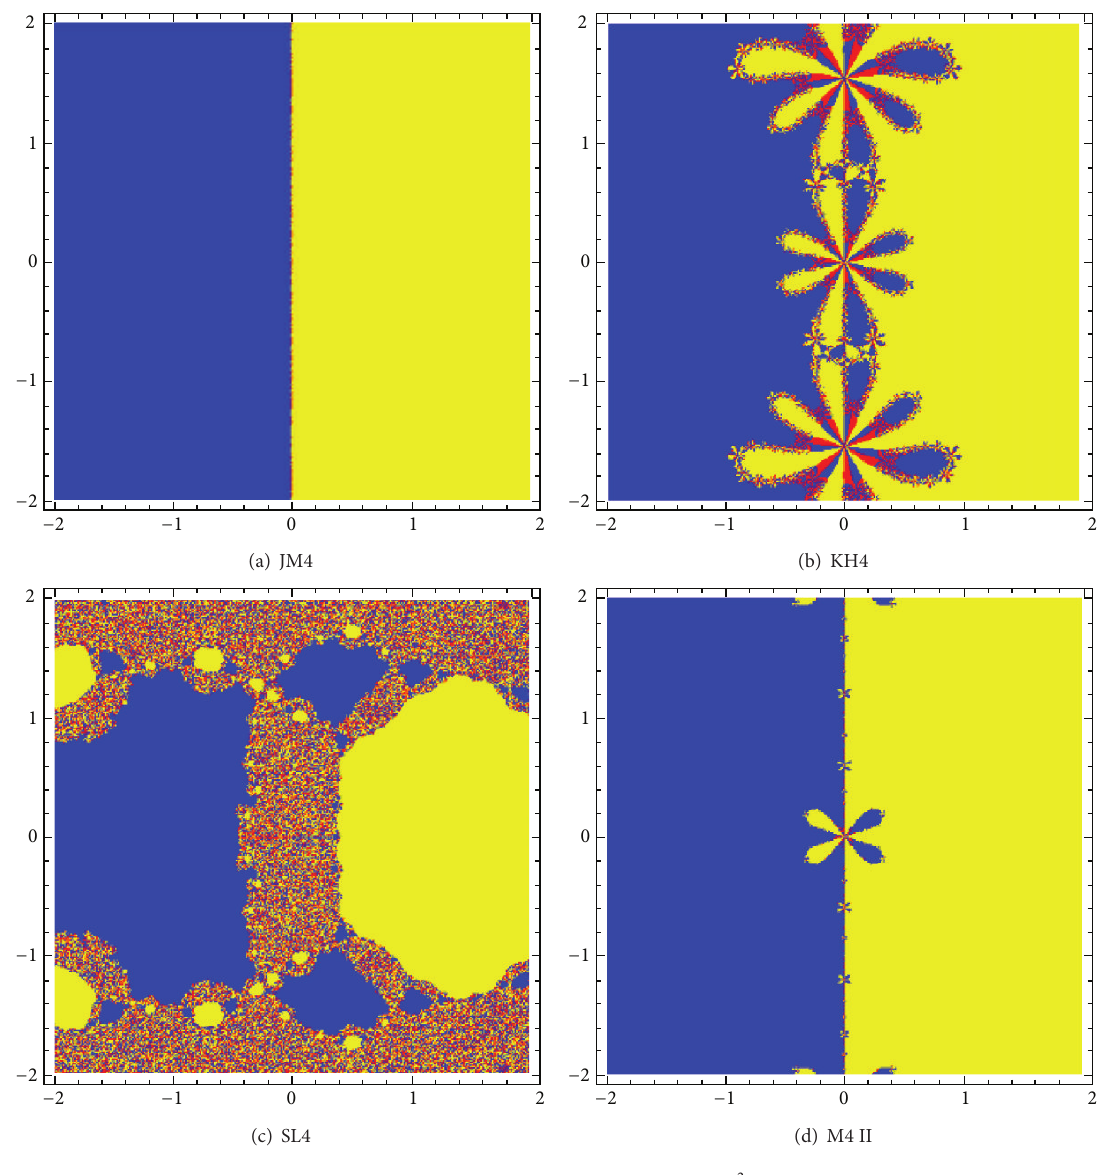
Figure 1: Basin of attraction for polynomial 𝑧 2 − 1